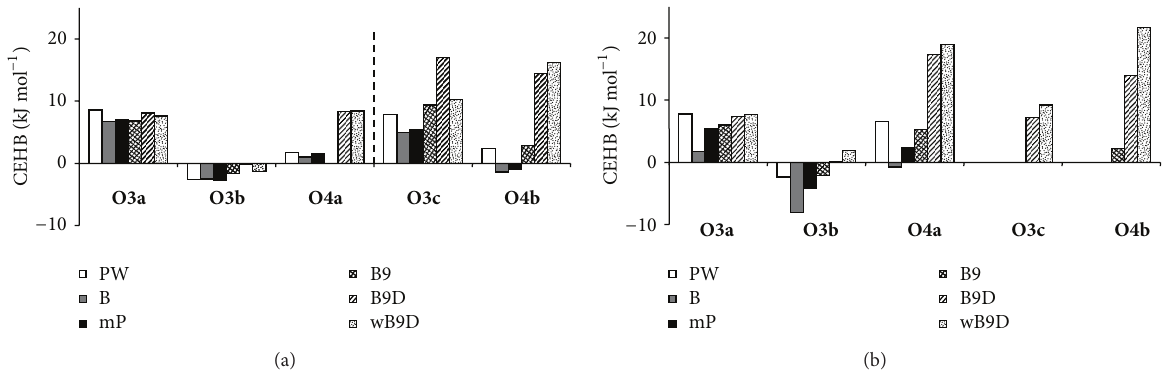
Figure 3: Variation of the CEHB values as a function of oligomer type and DFT, (a) prior and (b) after correction for BSSE.